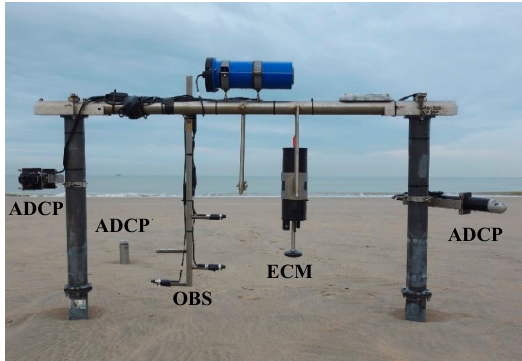
Figure 2. The intertidal measuring frame (1 m high, 2.2 m wide) with the down-looking Acoustic Doppler Current Profiler (ADCP), up-looking ADCP (not on the frame), three Optical Backscatter Sensors (OBS), Electromagnetic Current Meter (ECM), and up-looking ADCP.